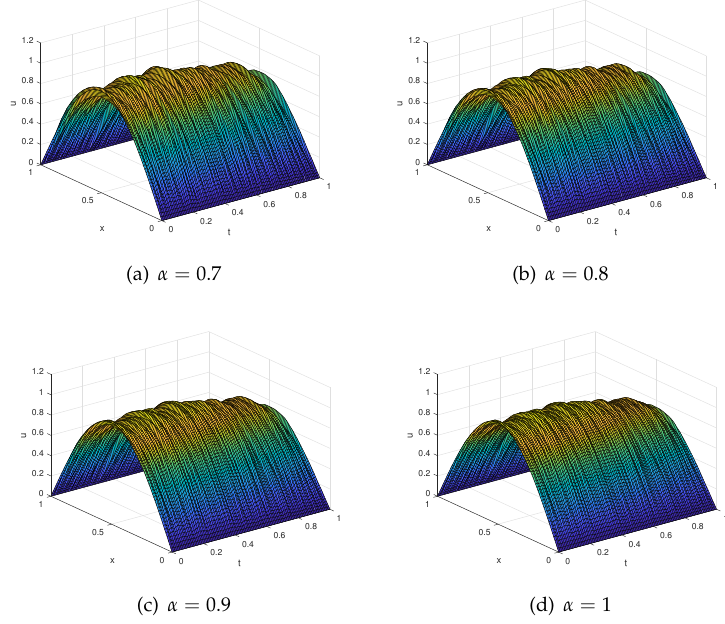
Figure 1. The approximation solutions of Example 1 with σ = 1.